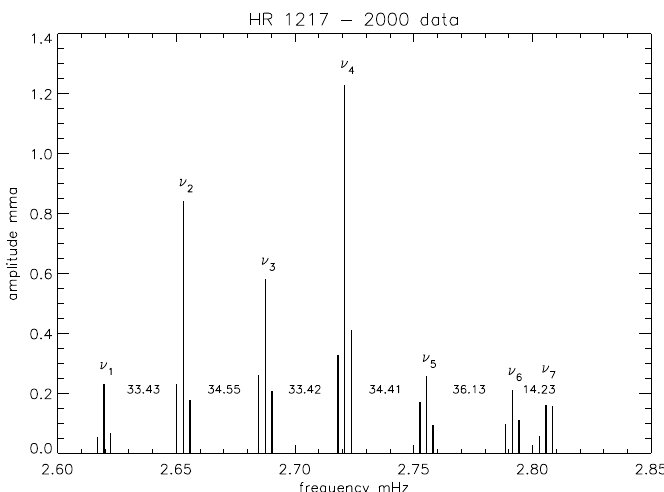
Fig. 4. A schematic amplitude spectrum extracted from Fig. 2 for the XCov20 HR 1217 data. The frequency separations are given in μ Hz.